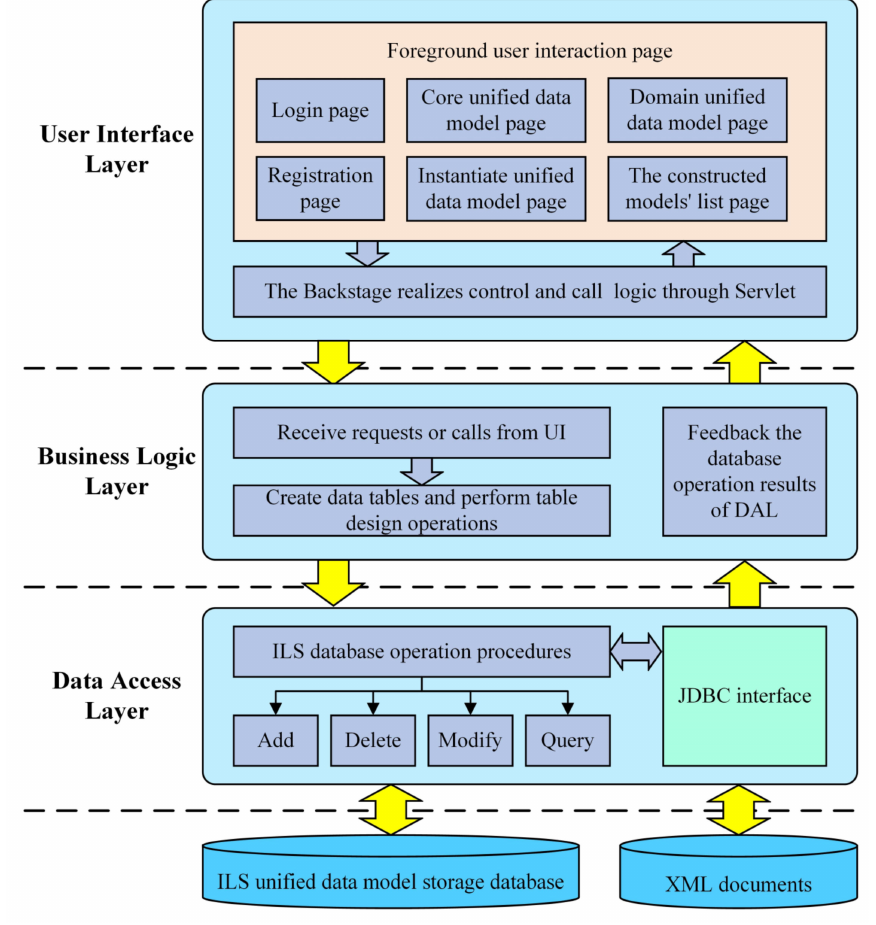
Figure 12. The software prototype